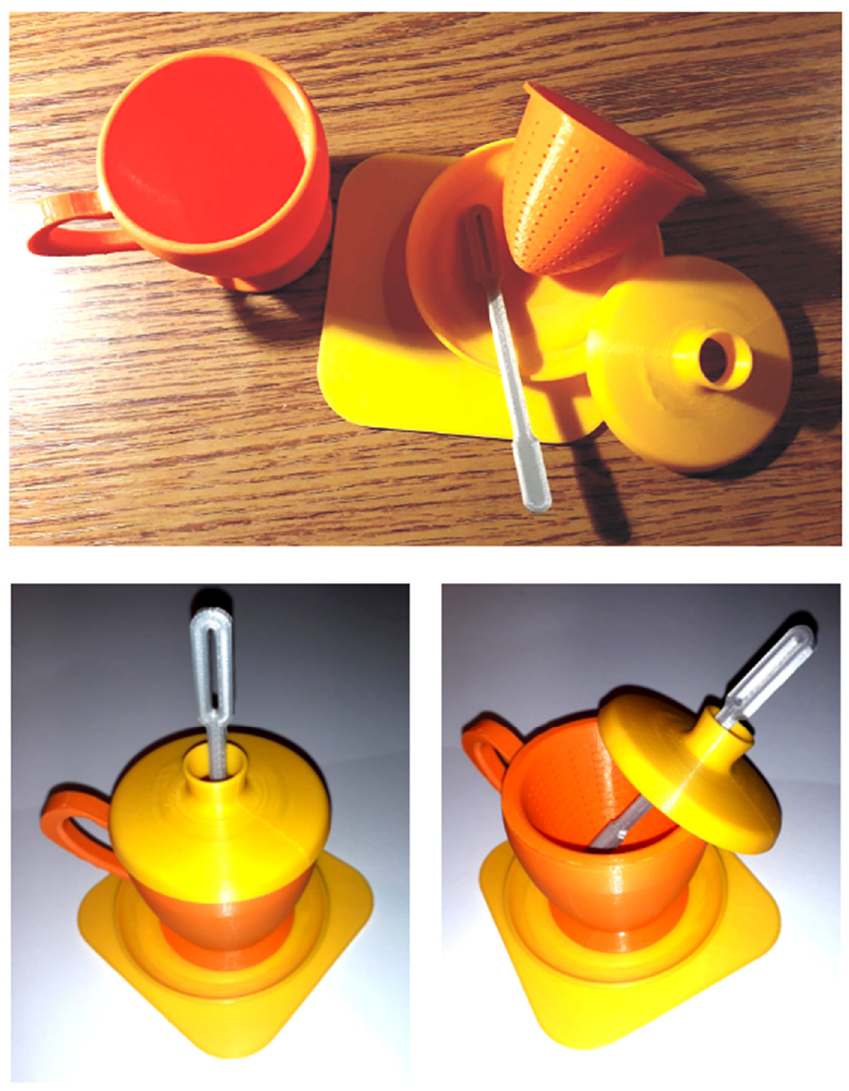
Figure 13. Children’s toy set—teacup (6 component parts).